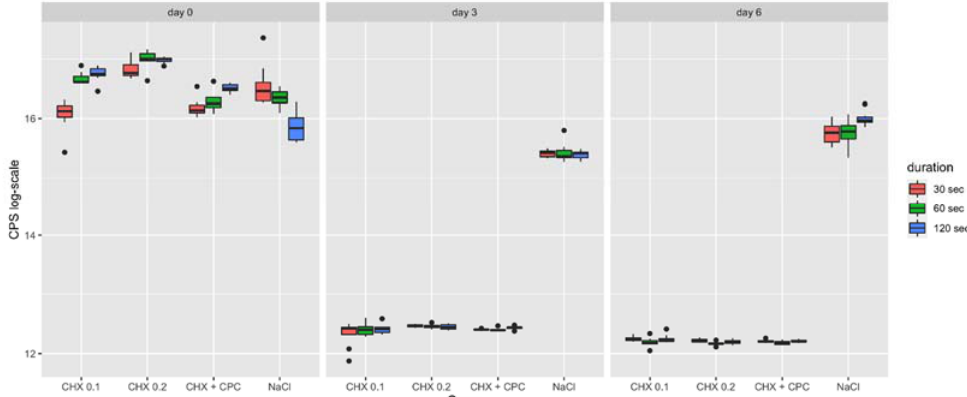
Figure 2. Boxplot representing the cytotoxicity on SaOS-2 cells following the different treatment procedures (i.e., CHX 0.1, CHX 0.2, CHX + CPC and NaCl for 30, 60 and 120 s) at day 0, 3 and 6. Data are expressed in counts per second (CPS).